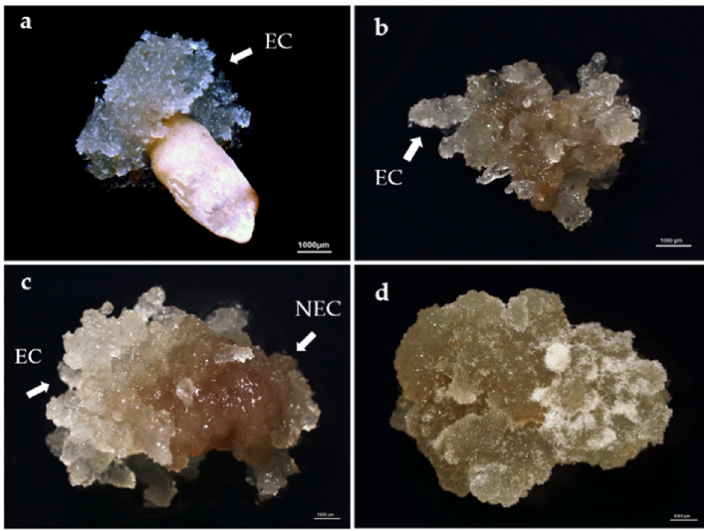
Figure 1. Tissues induction of L. principis-rupprechtii Mayr. ( a ) ETs extruded from micropyle. ( b ) ETs induced from brown tissues. ( c ) ETs induced from one side of loose brown NETs. ( d ) Yellow and brown non-ETs. Bars = 1000 µm.